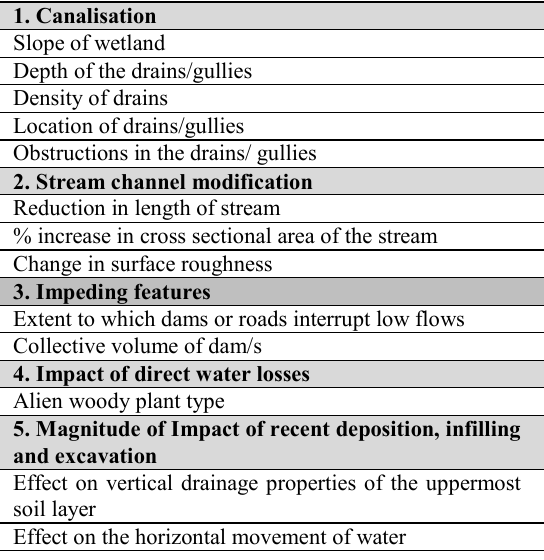
Table 1. Hydrological factors